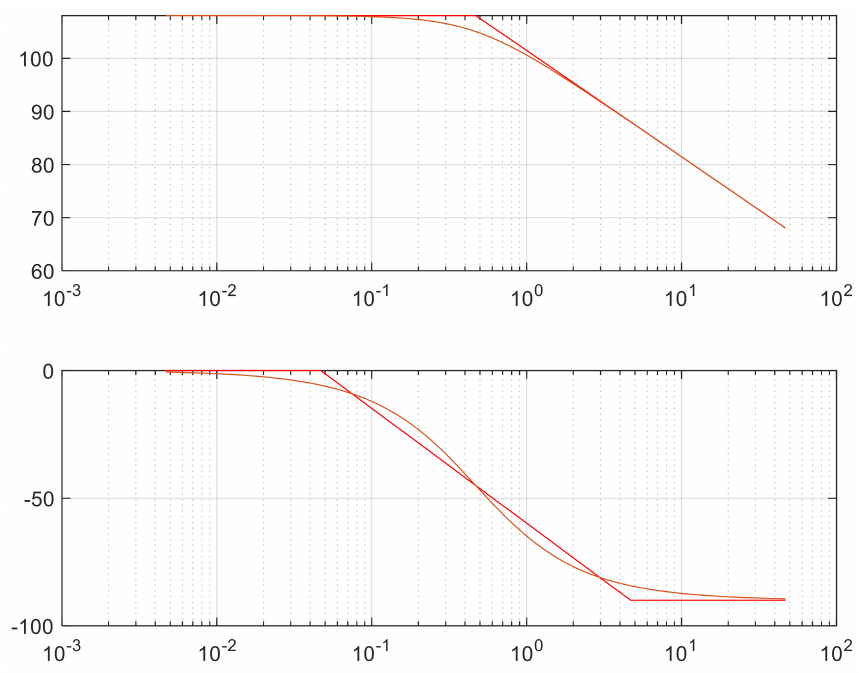
Figure A3. Bode plot of the open-loop transfer function G i ( s ) showing the asymptotes. The PI regulator in the inner current control loop